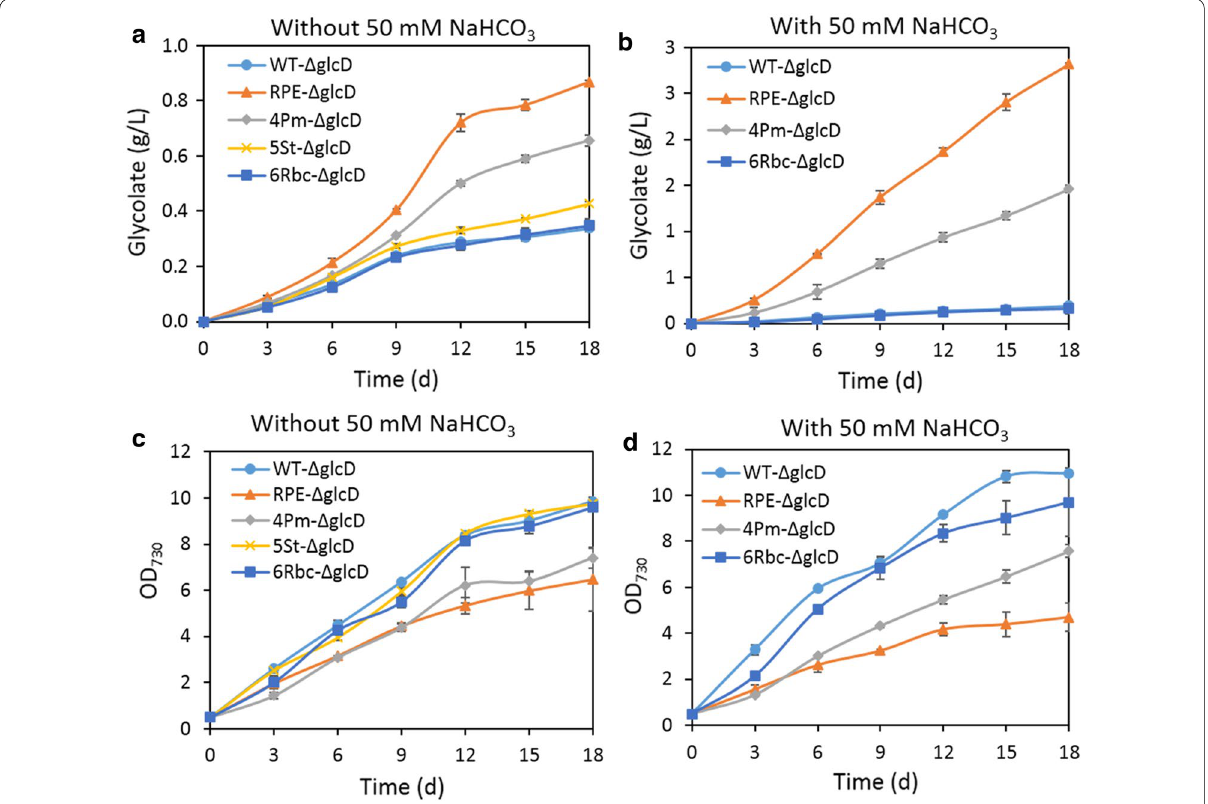
Fig. 3 Overexpression of Form II Rubisco increased glycolate production. Glycolate production ( a and b ), growth curve ( c and d ) of the Synechocystis strains expressing different Form II Rubiscos. The cells were cultivated without or with 50 mM NaHCO 3 at 30 o C under 100 µmol photons m − 2 s − 1 light intensity. Error bars represent standard deviations from biological triplicates conducted in three independent